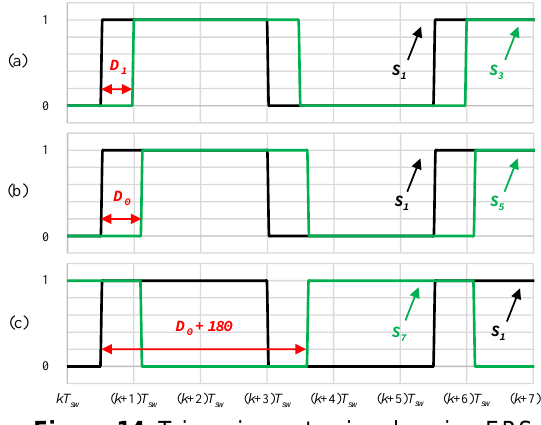
Figure 14. Triggering gate signals using EPS modulation: (a) S 1 , S 3 ; (b) S 1 , S 5 ; (c) S 1 , S 7 .